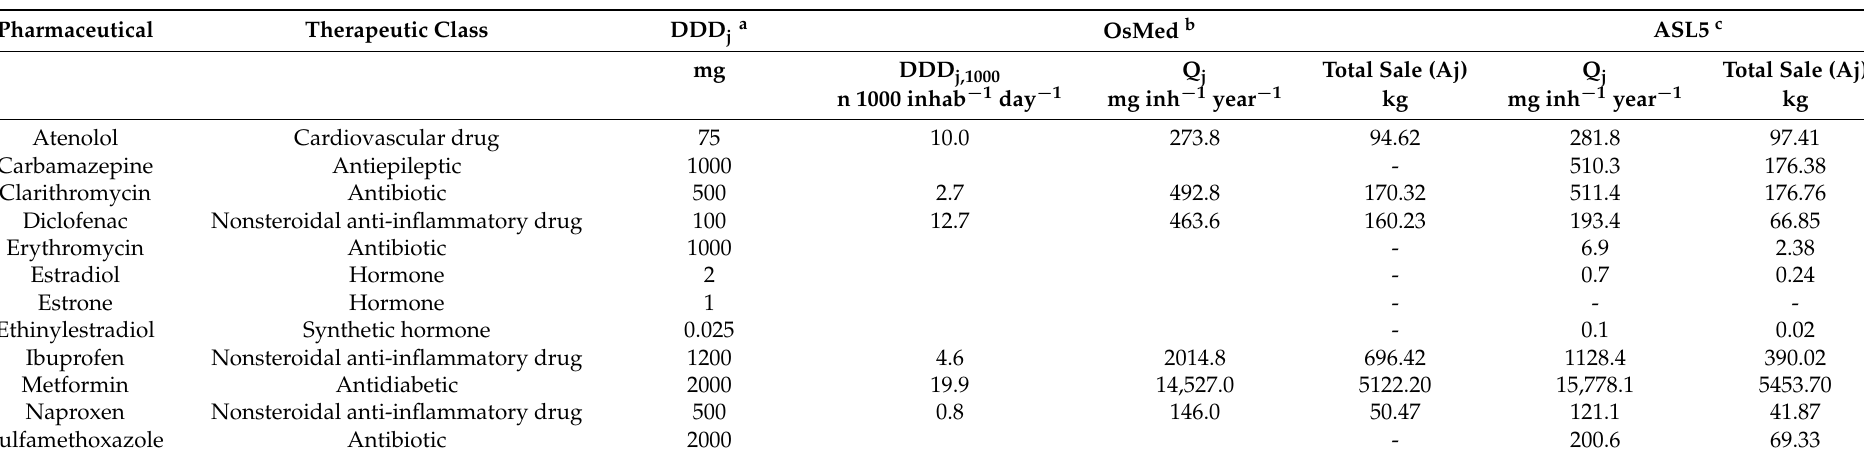
Table 1. Sale volumes of the selected pharmaceuticals per inhabitant (Q j ) and for the whole number of citizens of ASL5 (total sale), and other parameters used for the calculation of sale data. For each drug (j), the defined daily dose (DDD j ) and the DDD sold per one thousand inhabitants per day (DDD j,1000 ) obtained from the OsMed are